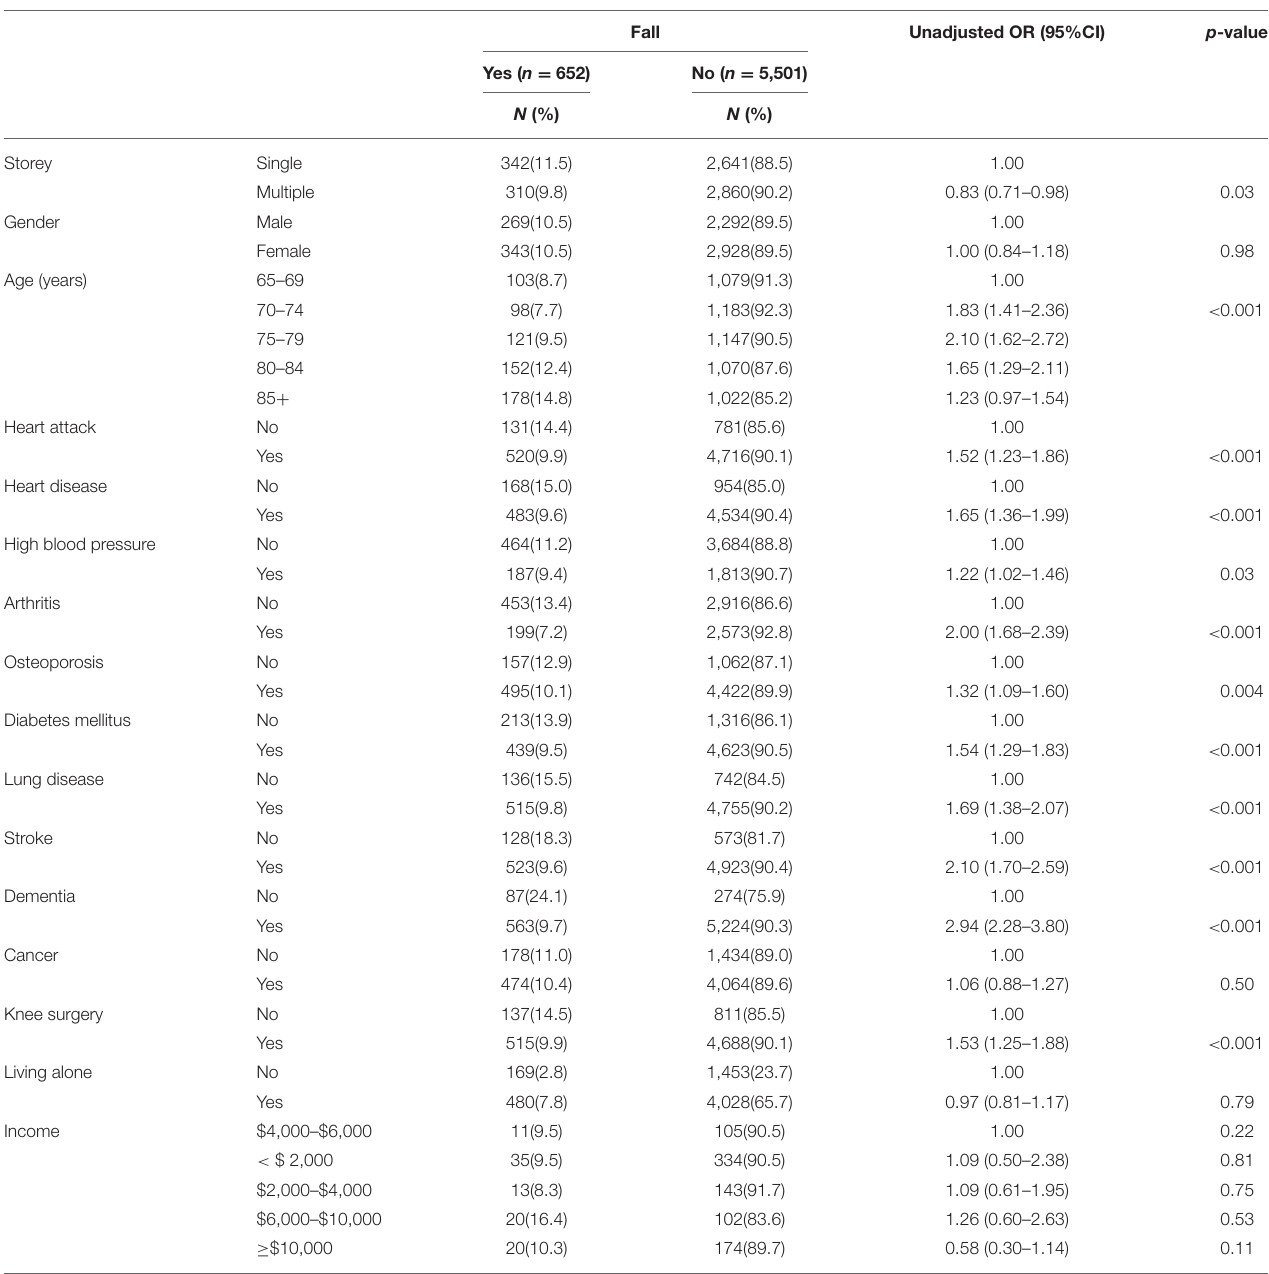
TABLE 1 | Univariate analysis on the factors associated with fall in the past month ( n = 6,153). Fall Unadjusted OR (95%CI) p